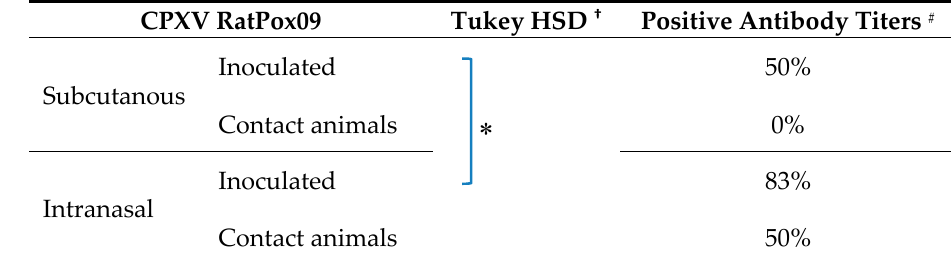
Table 5. Seroconversion rate of CPXV-inoculated bank voles inoculated with CPXV RatPox09 via different routes, and in contact animals at 14 dpi.